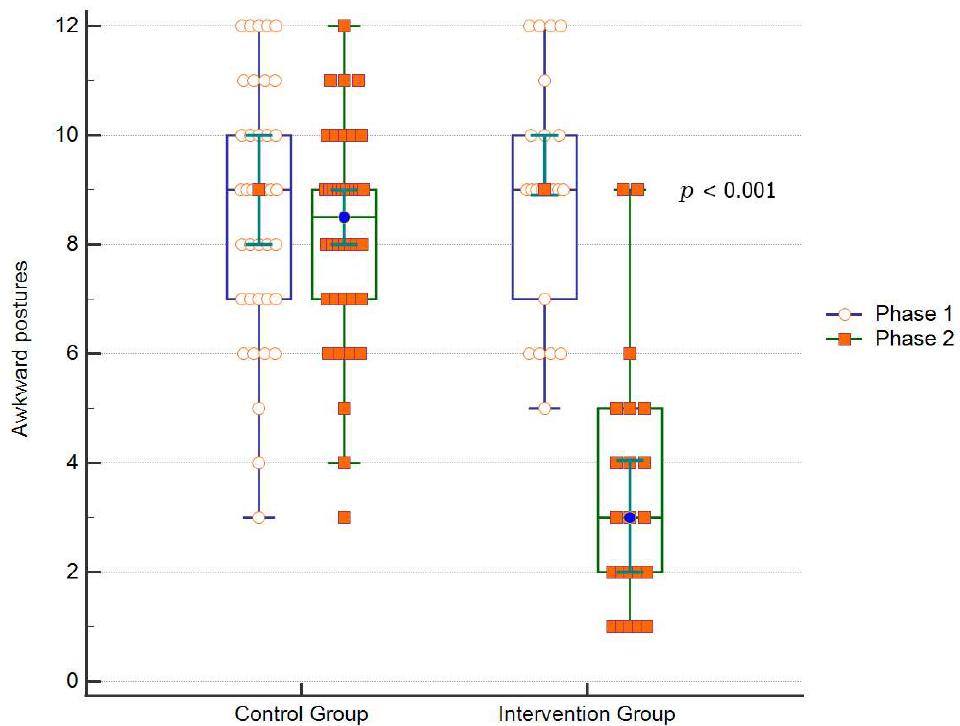
Figure 4. Distribution of the prevalence of awkward postures according to the groups, before (initial) and after (final) training.